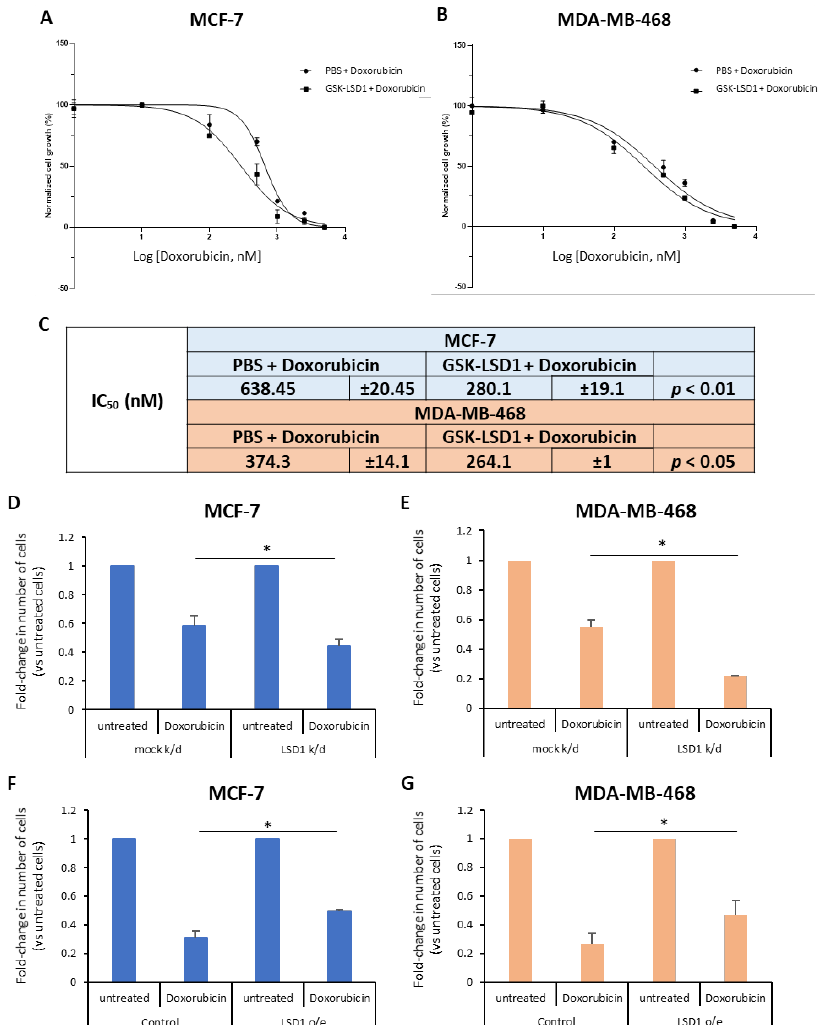
Figure 1. Lysine-specific demethylase 1 (LSD1) mediates doxorubicin resistance in breast cancer cells. ( A ) MCF-7 and ( B ) MDA-MB-468 breast cancer cells were treated with vehicle (phosphate-buffered saline, PBS) or GSK-LSD1 inhibitor (0.5 µ M) for 5 days before the addition of increasing concentrations (0–5 µ M) of doxorubicin for two more days. Cell confluency was measured using the Incucyte Zoom live cell analysis system. ( C ) The doxorubicin IC 50 values in MCF-7 and MDA-MB-468 cells with or without pretreatment with the inhibitor GSK-LSD1. IC 50 calculation was performed using Graphpad Prism version 8.01. Data from two independent experiments performed in triplicate are shown. ( D ) MCF-7 and ( E ) MDA-MB-468 breast cancer cells were knocked-down with an siRNA for LSD1. Four days post-transfection, cells were treated with doxorubicin for 24 h, and the number of live cells was counted. Mock knock-down was performed using a scrambled siRNA. ( F ) MCF-7 and ( G ) MDA-MB-468 breast cancer cells were transfected with an empty (control) or an LSD1 expression vector. Forty-eight hours post-transfection, cells were treated with doxorubicin for 24 h, and the number of live cells was counted. Error bars represent SEM. * p <